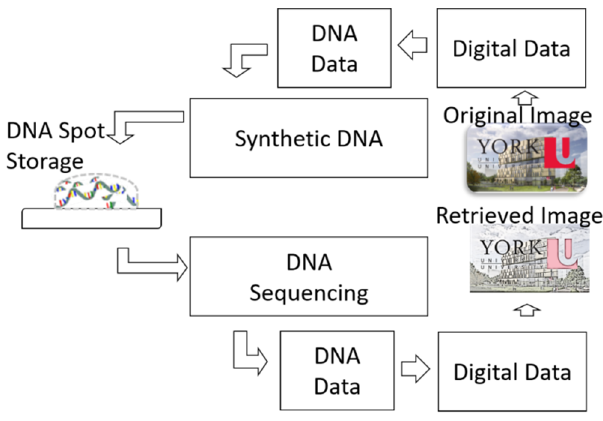
Figure 1. Illustration of the DNA storage